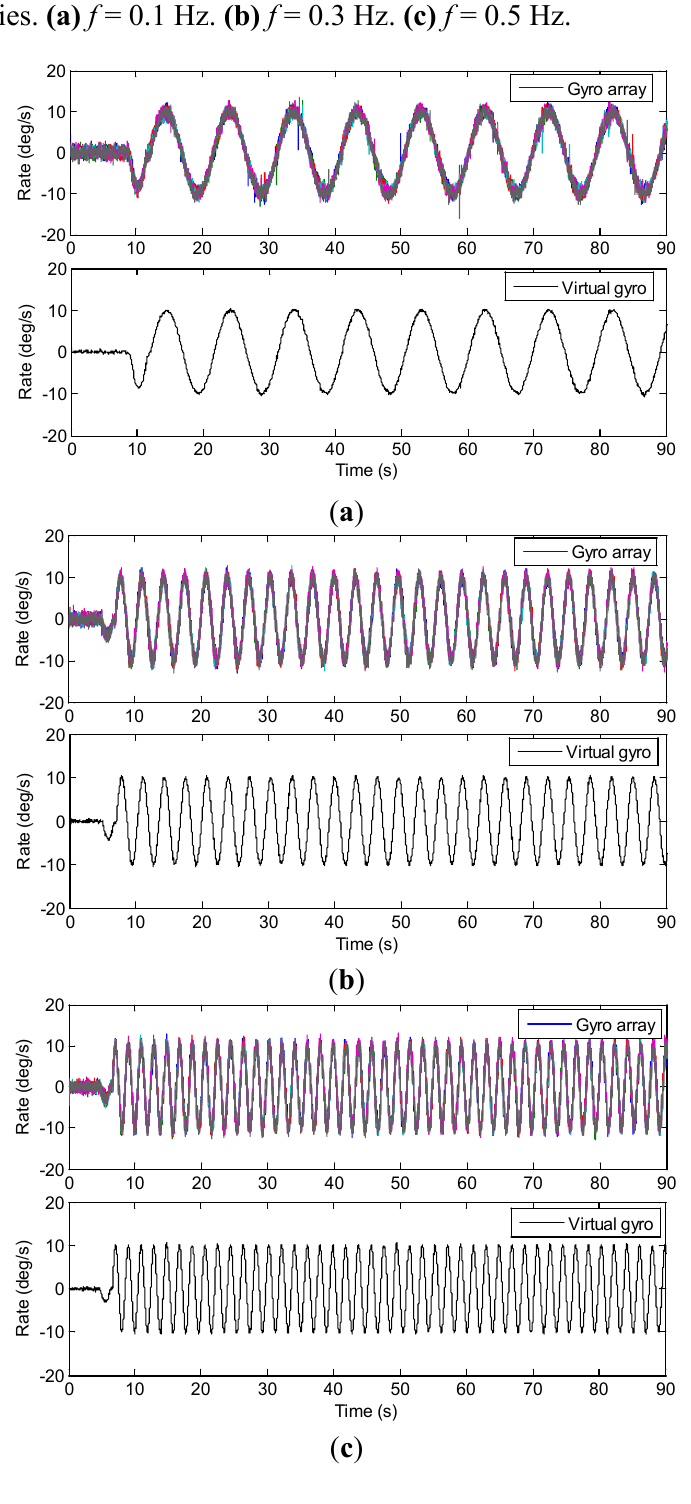
Figure 9. Swing rate test results of the virtual gyroscope for the input rate signals with various frequencies. (a) f = 0.1 Hz. (b) f = 0.3 Hz. (c) f = 0.5